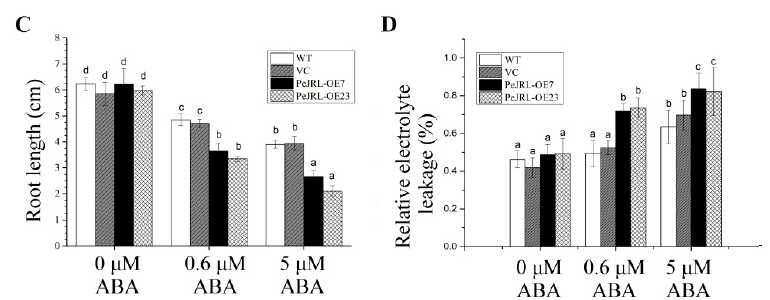
Figure 10. Abscisic acid (ABA) tests in wild-type (WT), vector control (VC), and PeJRL -transgenic Arabidopsis lines (OE7 and OE23). Seeds of WT, VC, and transgenic lines were allowed to germinate on MS medium supplemented with 0, 0.6 or 5 µ M ABA. Representative images show plant performance during seedling establishment ( A ) and root length ( B , C ) after 10 days of ABA treatment (0, 0.6 or 5 µ M). Each column in ( C ) corresponds to the mean of three independent experiments (70 seeds for each test), and bars represent the standard error of the mean. ( D ) Relative electrolyte leakage. Electrolyte leakage was measured after 10 days of ABA treatment (0, 0.6 or 5 µ M). Each column corresponds to the mean of three replicated experiments (20 seeds for each test) and bars represent the standard error of the mean. In C and D , columns labelled with different letters (a–d) denote significant differences at p < 0.05. Scale bar = 1 cm ( A , B